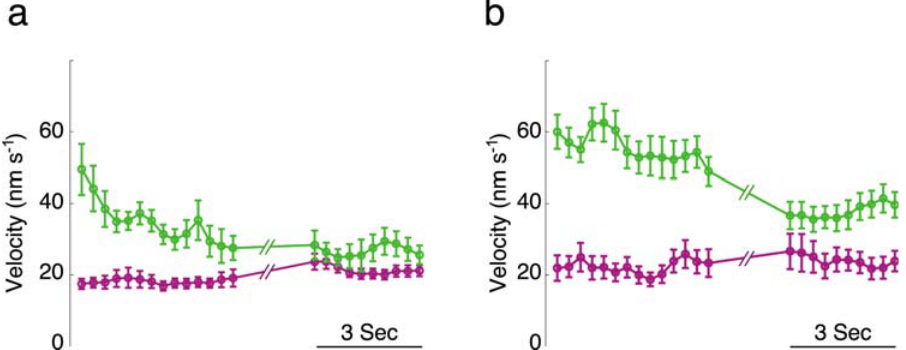
Figure 6. Tomosyn delays the immobilization of newcomer vesicles before fusion. (a) . Point-to-point velocity (ptpv) of newcomer (green) and resident (magenta) vesicles that fused in response to stimulation in control cells. The graph depicts the ptpv of vesicles during the first 4 s of their arrival near the membrane and then during the last 3 s before fusion. The ptpv of resident vesicles is shown for the first 4 s of acquisition and the last 3 s before fusion (magenta). (b) . As in a , ptpv for resident and newcomer vesicles in tomosyn-overexpressing